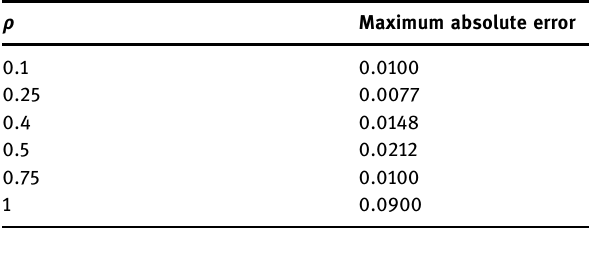
Table 2: Error using D ( TQ ) M for M N t 21, 0.1